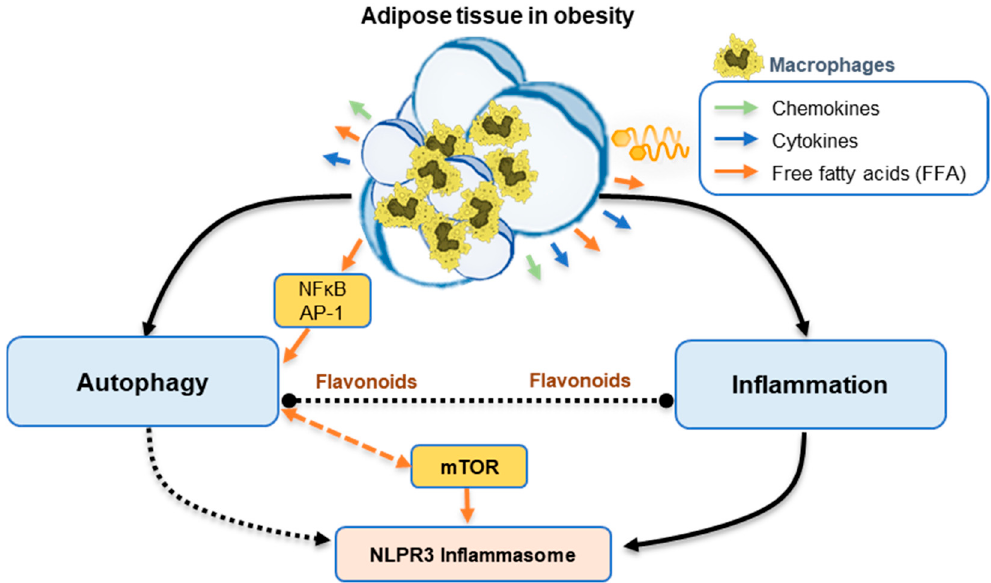
Figure 2. Scheme of the relationship between inflammation and autophagy in obesity.